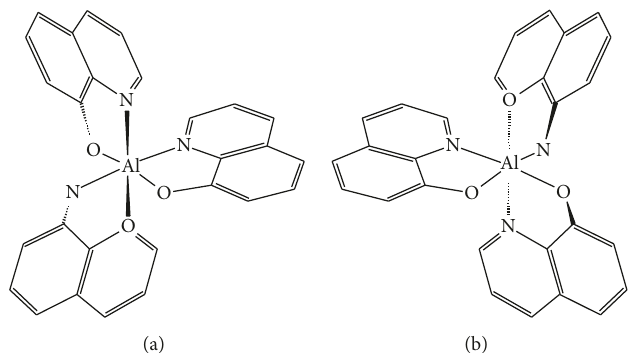
Figure 1: Structures of Alq 3 isomers: meridional (a) and facial